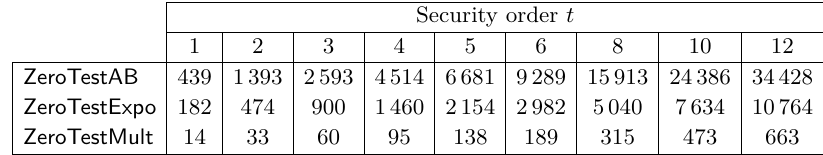
Table 3: Operation count for zero testing with arithmetic masking modulo q , with n = t +1 shares and q =